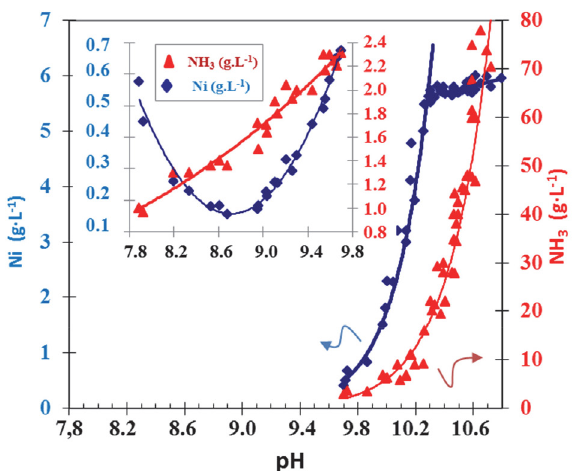
Figure 3. Profile of nickel and ammonia dissolved versus pH at 25 °C in the mini-column (Stage 01). Ni/S = 2.66, Ni/[SO 4 2– ] = 5.08, Ni/[S 2 O 32– ] = 3.11, NH 3 /CO 2 = 1.73